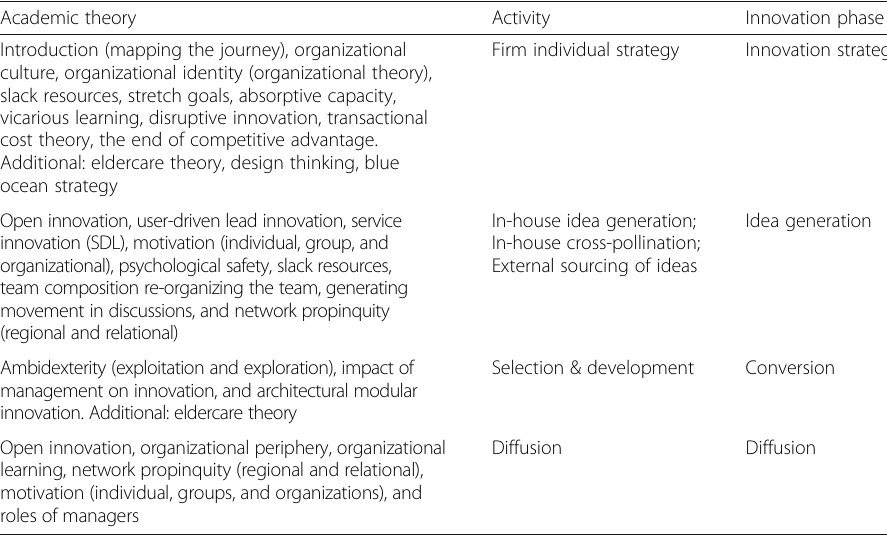
Table 4 Innovation theories related to each innovation phase Academic